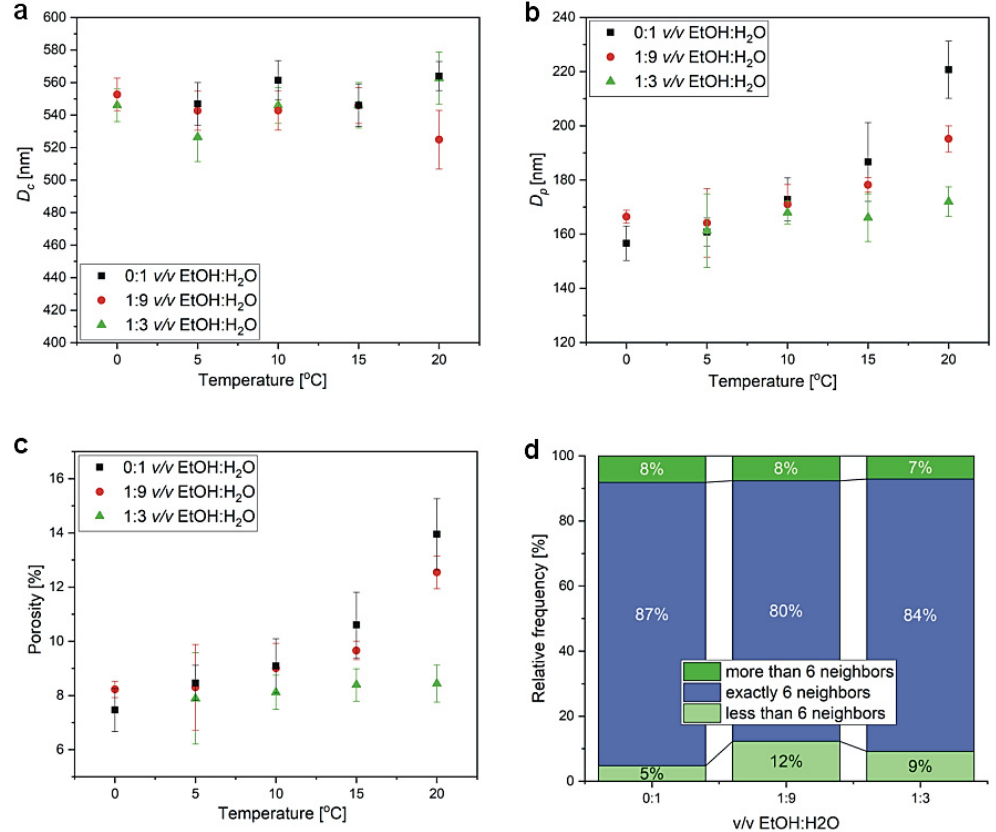
Figure 7. Interpore distance (D c ) ( a ), pore diameter (D p ) ( b ), porosity of PAA ( c ) vs. temperature for different ethanol fractions; and the ordering degree of pores after II anodization calculated for PAAs formed at 15 °C ( d ).